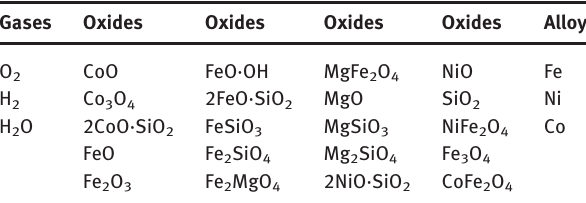
Table 1: Phases and species utilized in the equilibrium calculations for the reduction of the nickeliferous limonitic laterite ore by